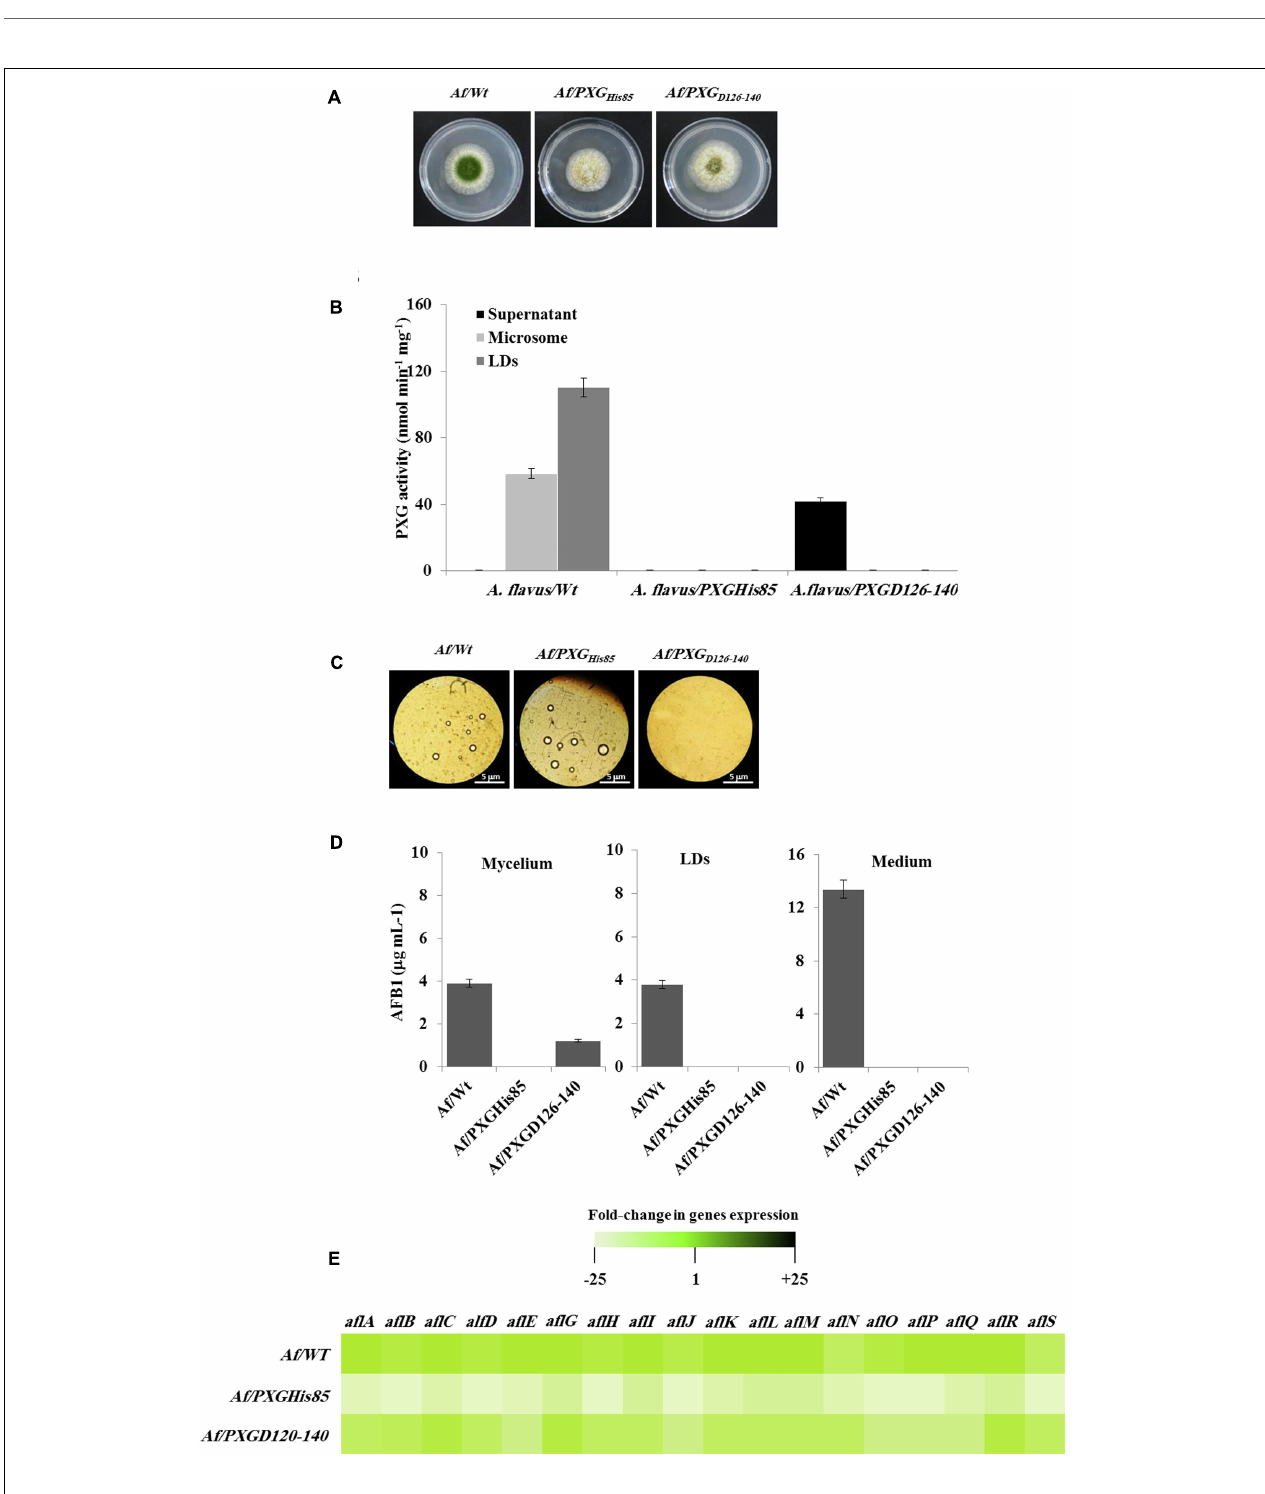
FIGURE 7 | Effect of AfPXG enzymatic activity and the absence of its transmembrane domain on biosynthesis and/or export of AFB1. (A) Growth of Af/AfPXG His85 , Af/PXG D126 − 140 lines compared with Af/WT . (B) PXG activity in supernatant (S), microsomes (M), and lipid droplets (LDs) isolated from the Af/AfPXG His85 , Af/PXG D126 − 140 lines compared with Af/WT . (C) Light micrographs of the isolated LDs from fungal tissue Af/AfPXG His85 , Af/PXG D126 − 140 lines compared with Af/WT , respectively, on day 7. Recovered LDs were observed under a light microscope and the images were taken at a magnification of 40 × . Bar represents 5 mm. (D) Quantification of AFB1 in the fungal mycelium, LDs and in the culture medium of Af/AfPXG His85 , Af/PXG D126 − 140 lines compared with Af/WT , respectively, on day 7. (E) Transcript levels of AFB1-biosynthesis genes in fungal tissue of Af/AfPXG His85 , Af/PXG D126 − 140 lines compared with Af/WT were evaluated by qRT-PCR. The color scale (white–green–black) indicates relative changes of transcript abundance of –25-, 1-, and +25-fold, respectively. For each gene, the expression level in Af/WT was defined as 1. The measurements were done in triplicate. Values are the means ± SD ( n = 3).